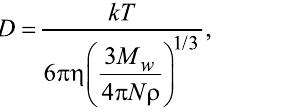
double-stranded DNA is ≈ 2 × 10 − 15 m 2 . The YOYO-1 concen- tration is 5 nM, and the frame time is 50 ms. Thus, every frame has 0.02 YOYO-1 molecules that hit every 1 μ m length of a DNA molecule (0.4 s − 1 ). This value is consistent with our mea- surement (Figure 8c). The slope of the 1.9 W cm − 2 curve at the first 10 s is ≈ 600 counts/s when photobleaching is insignificant. The PSF peak intensity at this laser power is ≈ 100 counts, representing a total photocount per molecule of ≈ 1400. Thus,